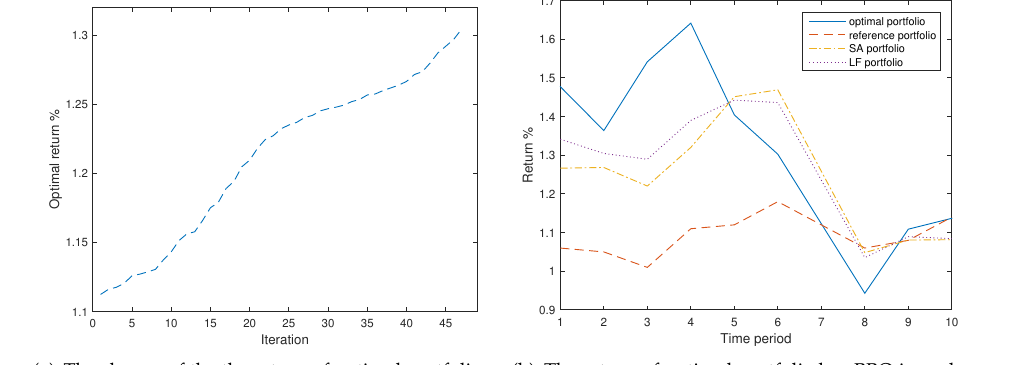
Figure 7. The performance of the ε BBO and the optimal portfolio in X ∈ [ − 1,2 ] of model (29).